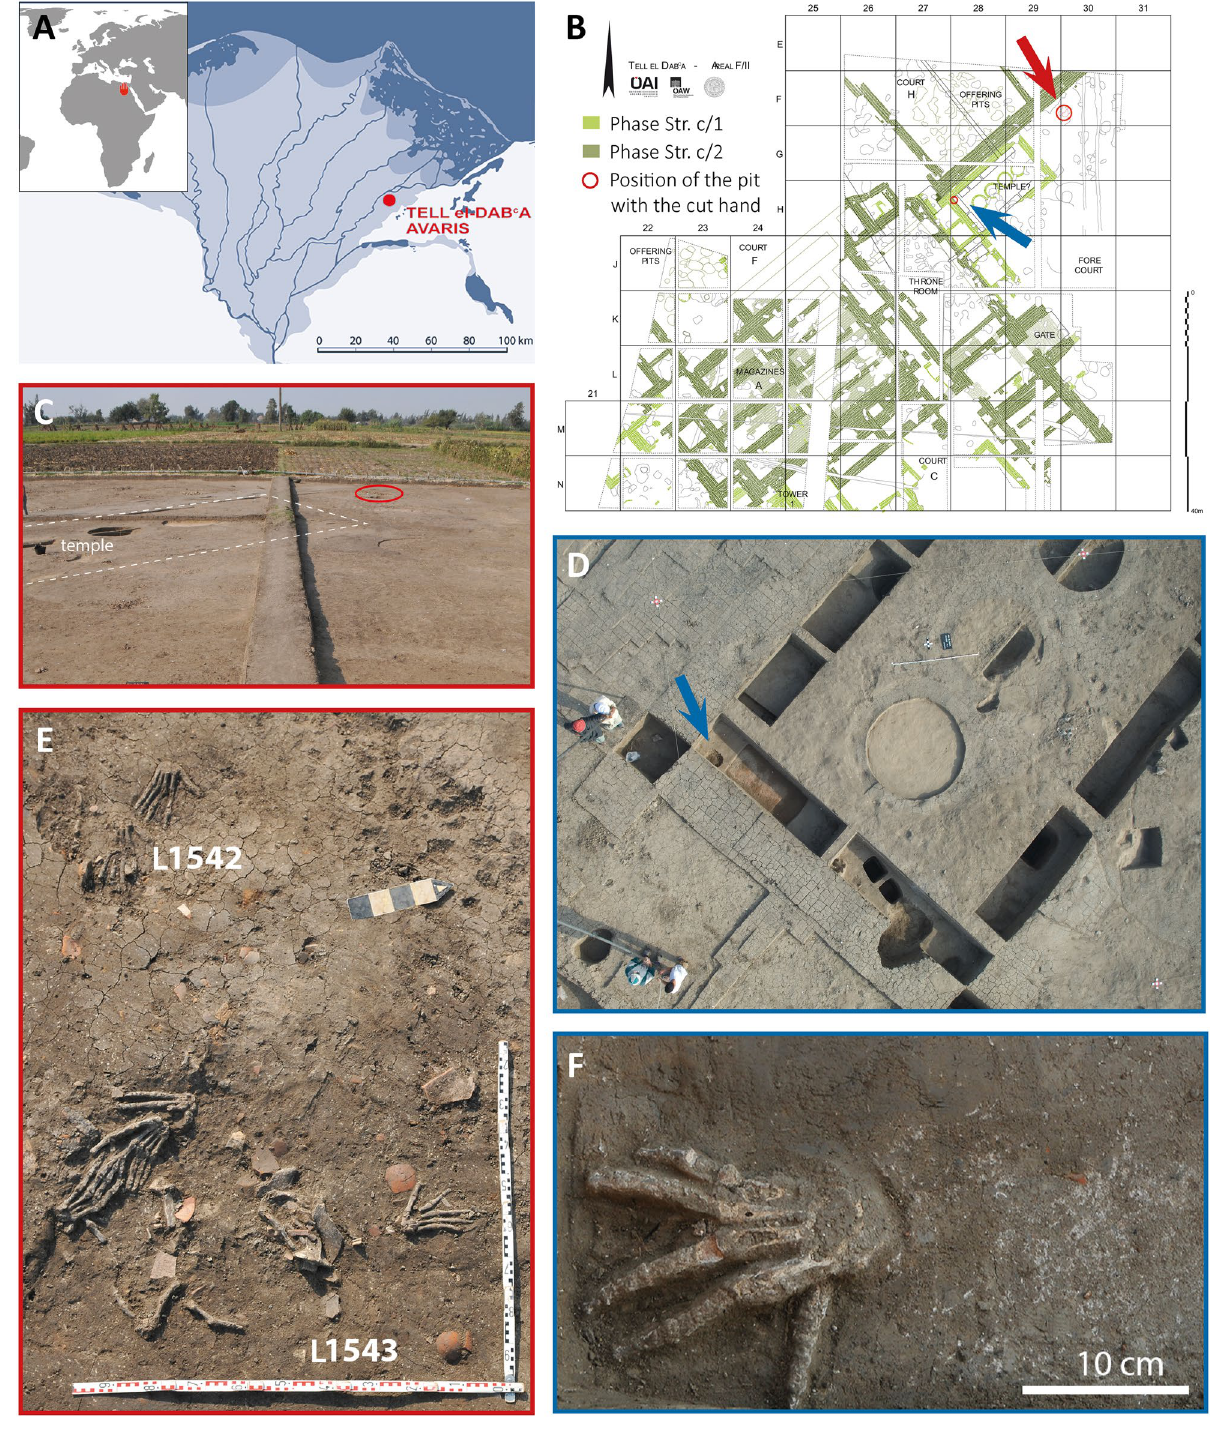
Figure 1. Archaeological evidence of severed hands in Hyksos Period Tell el-Dab‘a, Northern Egypt (images ÖAI, M. Bietak): ( A ) Nile Delta, Northern Egypt (Apple maps) and position of the site Tell el-Dab‘a/Avaris in the Nile Delta. This map has been modified from Fig. 1 (drawn by Nicola Math, modified by Dominik Fill, Austrian Academy of Sciences) in: Manfred Bietak, "Hyksos" in "Hyksos," R. Bagnell, et al. (eds.), Encyclopedia of Ancient History, vol. 6, 1st edition, Malden, MA- Oxford 2013: Wiley-Blackwell, 3356–3362. To publish the map under a CC BY open access license is permitted by the copyright holder Manfred Bietak. ( B ) Northern part of the Hyksos Palace at Tell el-Dab‘a, Phase E1-D3 (after Bietak et al. 2012/13). Red arrow indicating Pit L1542 and 1543, blue arrow indicating Pit L1777. ( C ) Overview of the area of Pit L1542 and 1543 (red circle), the excavation layer closely beneath the modern surface in the agricultural area. ( D ) South wall of a later added broad-room building built against the western enclosure wall of the palace’s forecourt. Pit L 1777 in front of the throne room (indicated by the arrow). ( E ) Overview of the 11 right hands in the Pits L1542 and L1543. ( F ) Single right hand on its palmar surface with wide-splayed